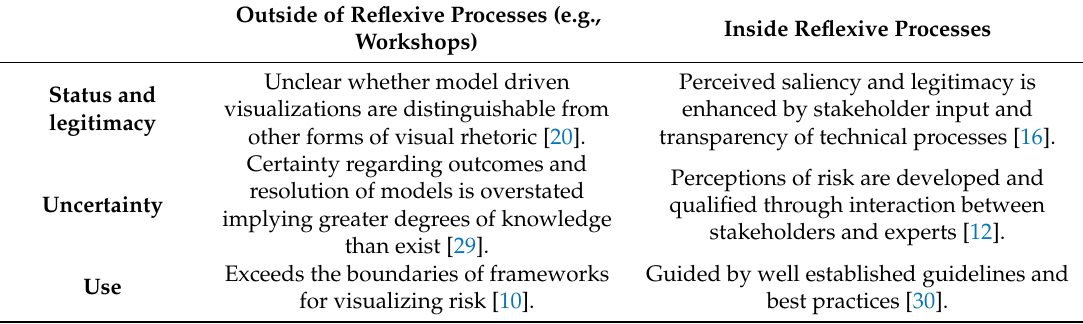
Table 1. Summary of issues raised by use of realistic simulation-based visualizations outside of expert-led workshop processes. These issues may apply more broadly to other types of visualizations. Outside of Reflexive Processes (e.g., Inside Reflexive Processes Workshops) Unclear whether model driven Perceived saliency and legitimacy is Status and visualizations are distinguishable from enhanced by stakeholder input and legitimacy other forms of visual rhetoric [20]. transparency of technical processes [16]. Certainty regarding outcomes and Perceptions of risk are developed and resolution of models is overstated Uncertainty qualified through interaction between implying greater degrees of knowledge stakeholders and experts [12]. than exist [29]. Exceeds the boundaries of frameworks Guided by well established guidelines and Use for visualizing risk [10]. best practices